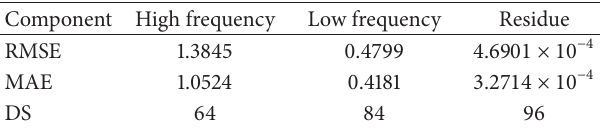
Figure 3: DVV-plots.